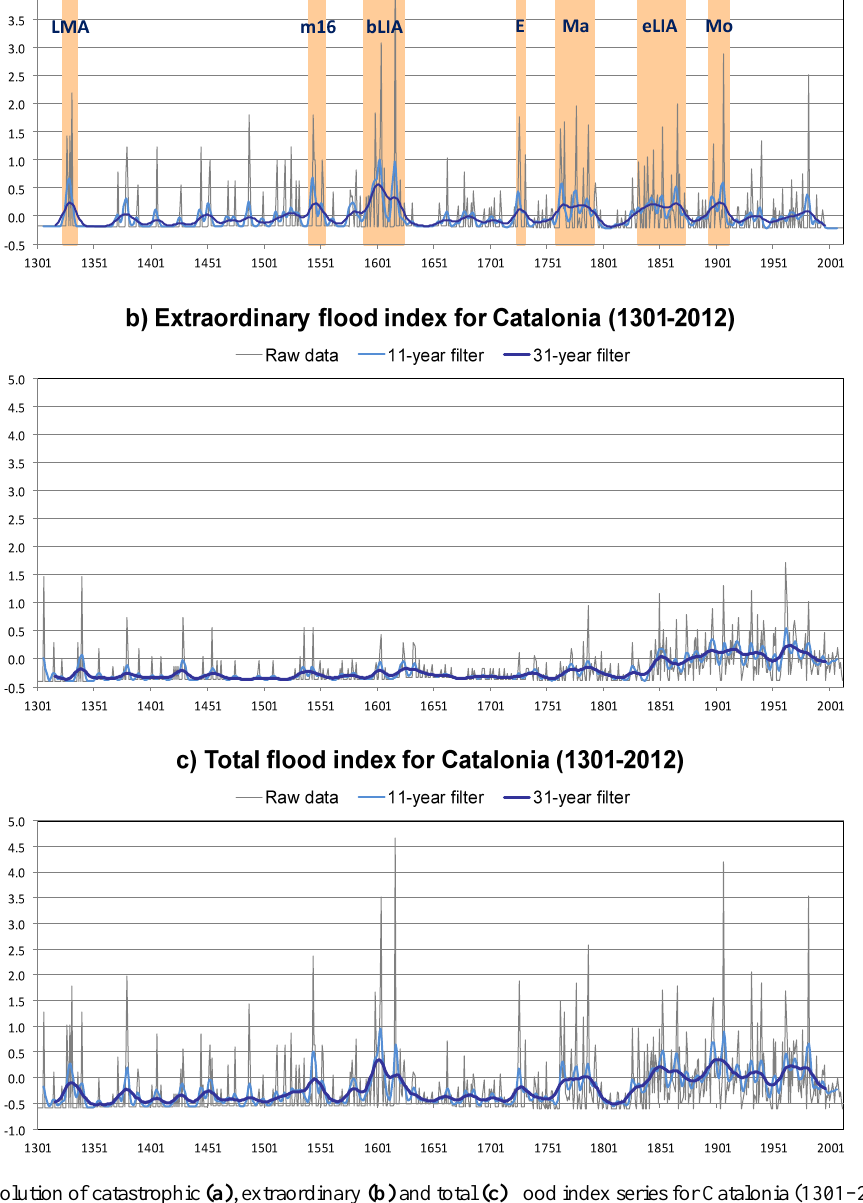
Figure 3. Temporal evolution of catastrophic (a) , extraordinary (b) and total (c) flood index series for Catalonia (1301–2012). Data smoothed by low-pass Gaussian filters of 31 and 11 years are also displayed. Anomalous periods of high catastrophic flood frequency and periods of solar minimum (following Usoskin et al., 2007) are highlighted in (a) : LMA (late Middle Age oscillation), m16 (mid-sixteenth century osc.), bLIA (beginning of LIA osc.), E (“Enlightened” osc.), Ma (Maldà osc.), eLIA (end of LIA oscillation) and Mo (“Modernist”